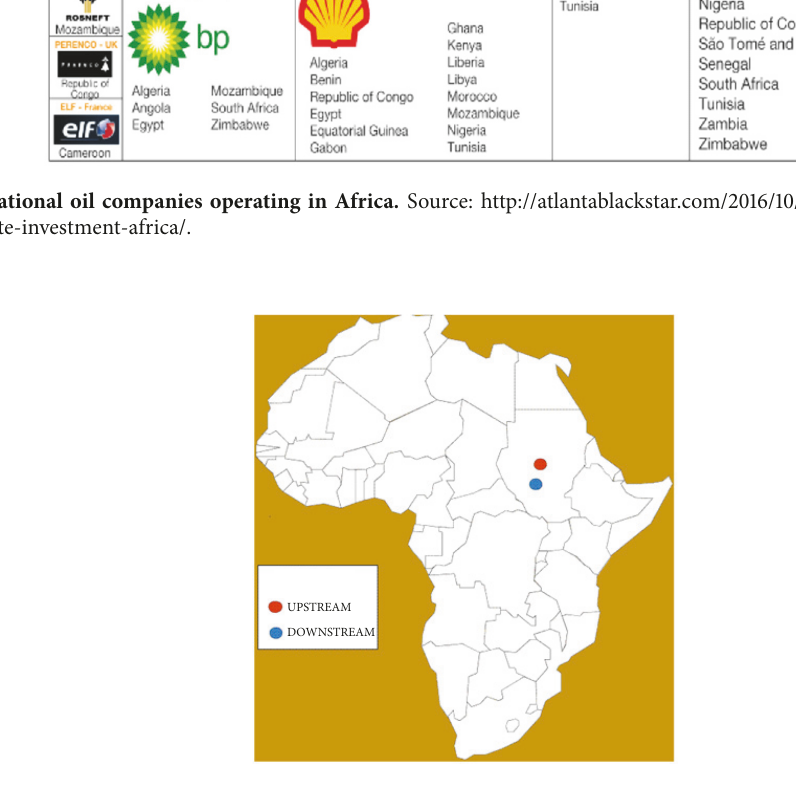
Figure 2: China’s footprint in Africa’s energy sector 2000. Source: http://www.ide.go.jp/English/Data/Africa file/Manualreport/cia